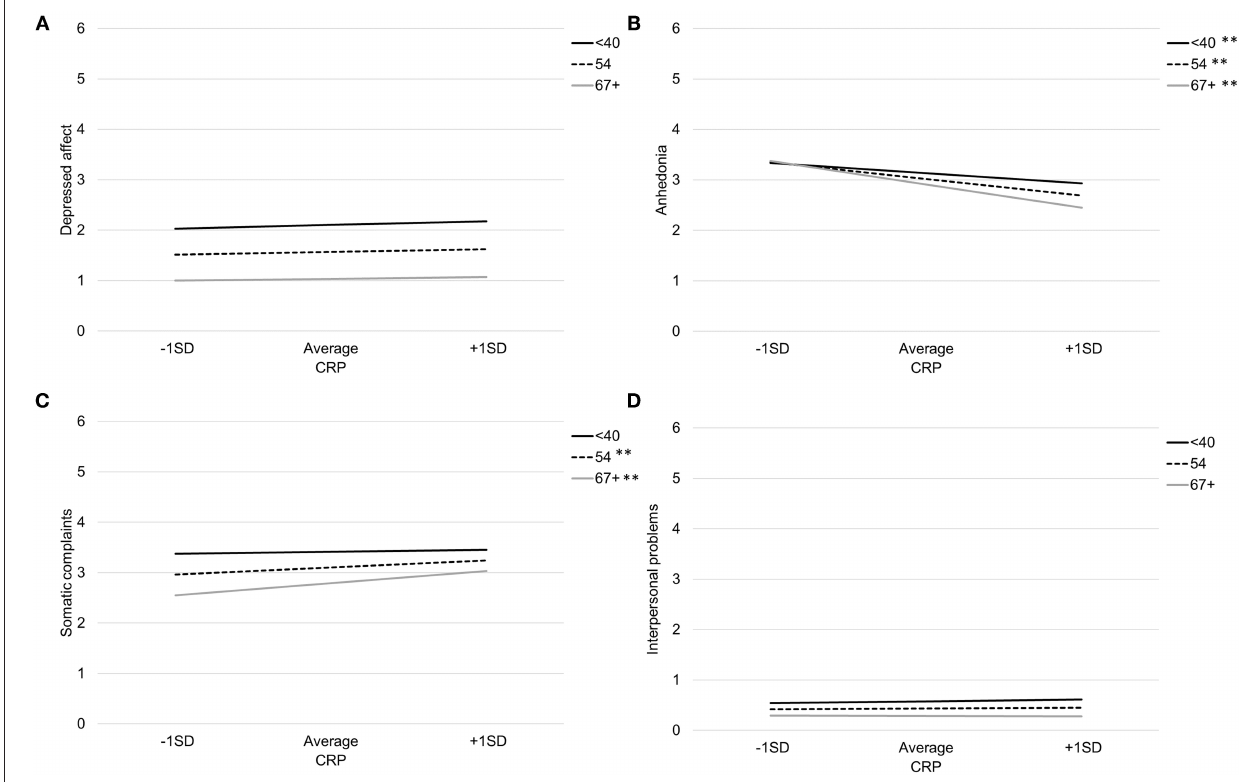
FIGURE 1 | Association between CRP and depressed affect (A) , anhedonia (B) , somatic complaints (C) , and interpersonal problems (D) by age. Note: ** p < 0.007, * p < 0.05.